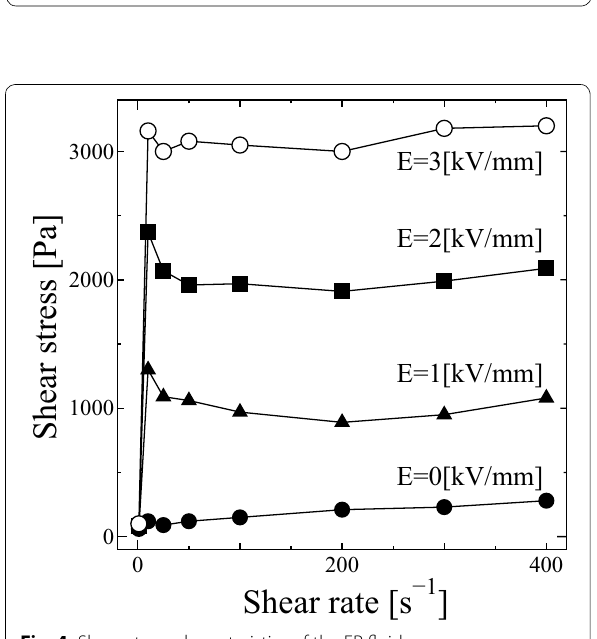
Fig. 4 Shear stress characteristics of the ER